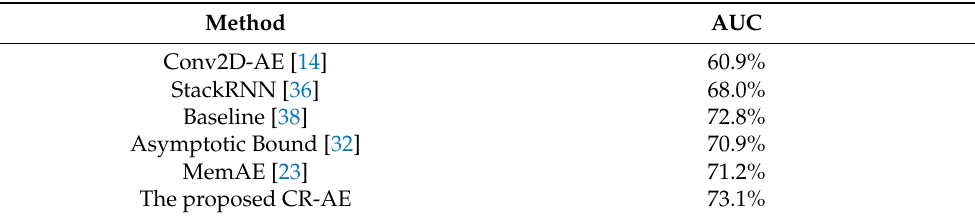
Table 3. Comparison with the state-of-the-art methods in terms of AUC% on the ShanghaiTech